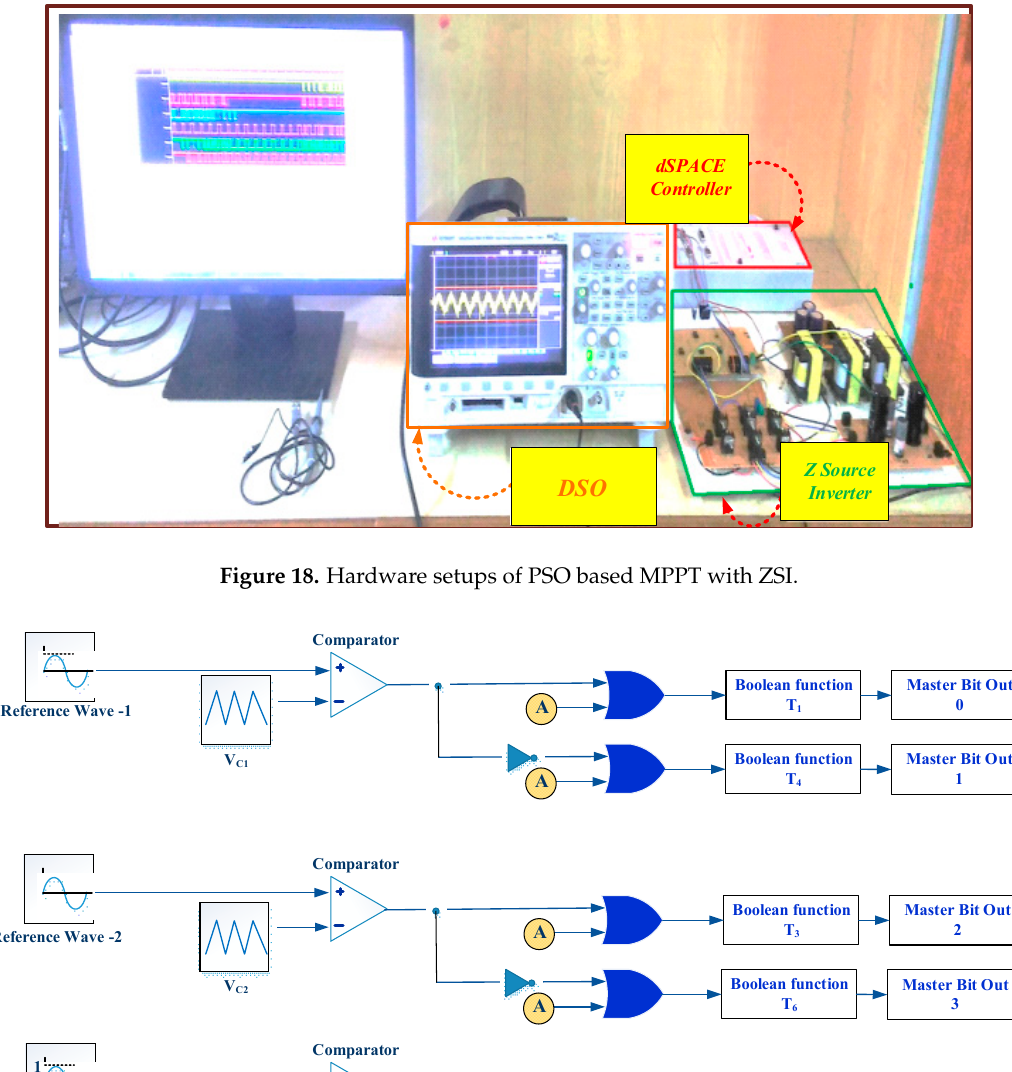
Figure 19. SPWM generation in dspace.